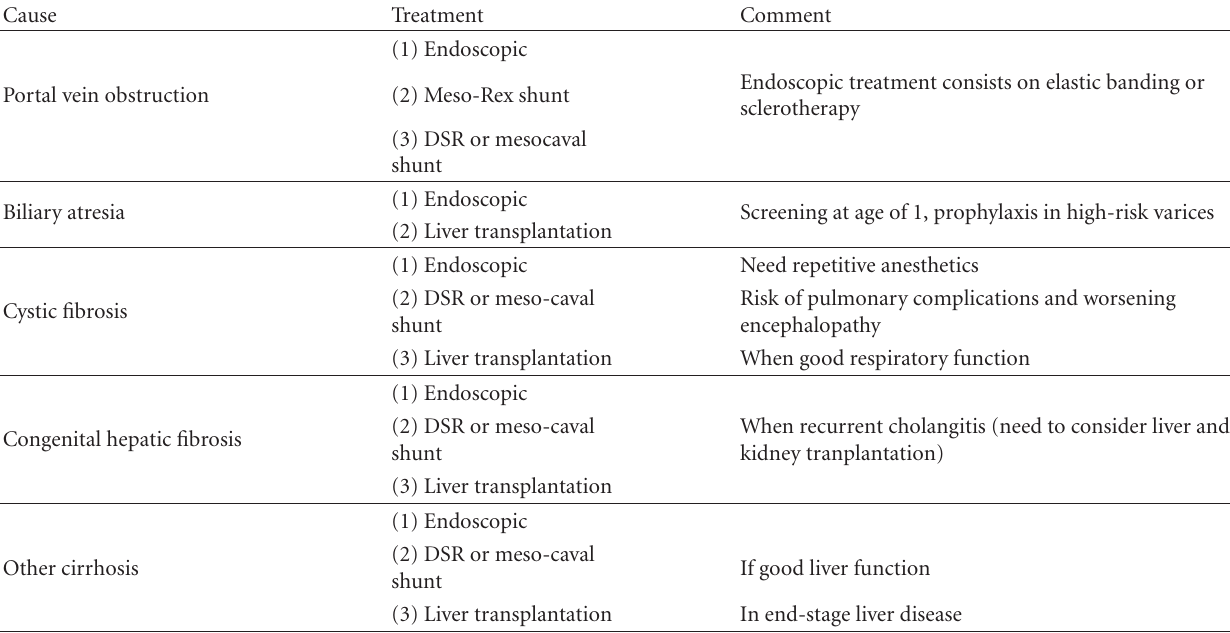
Table 1: Common causes of portal hypertension in children and suggested